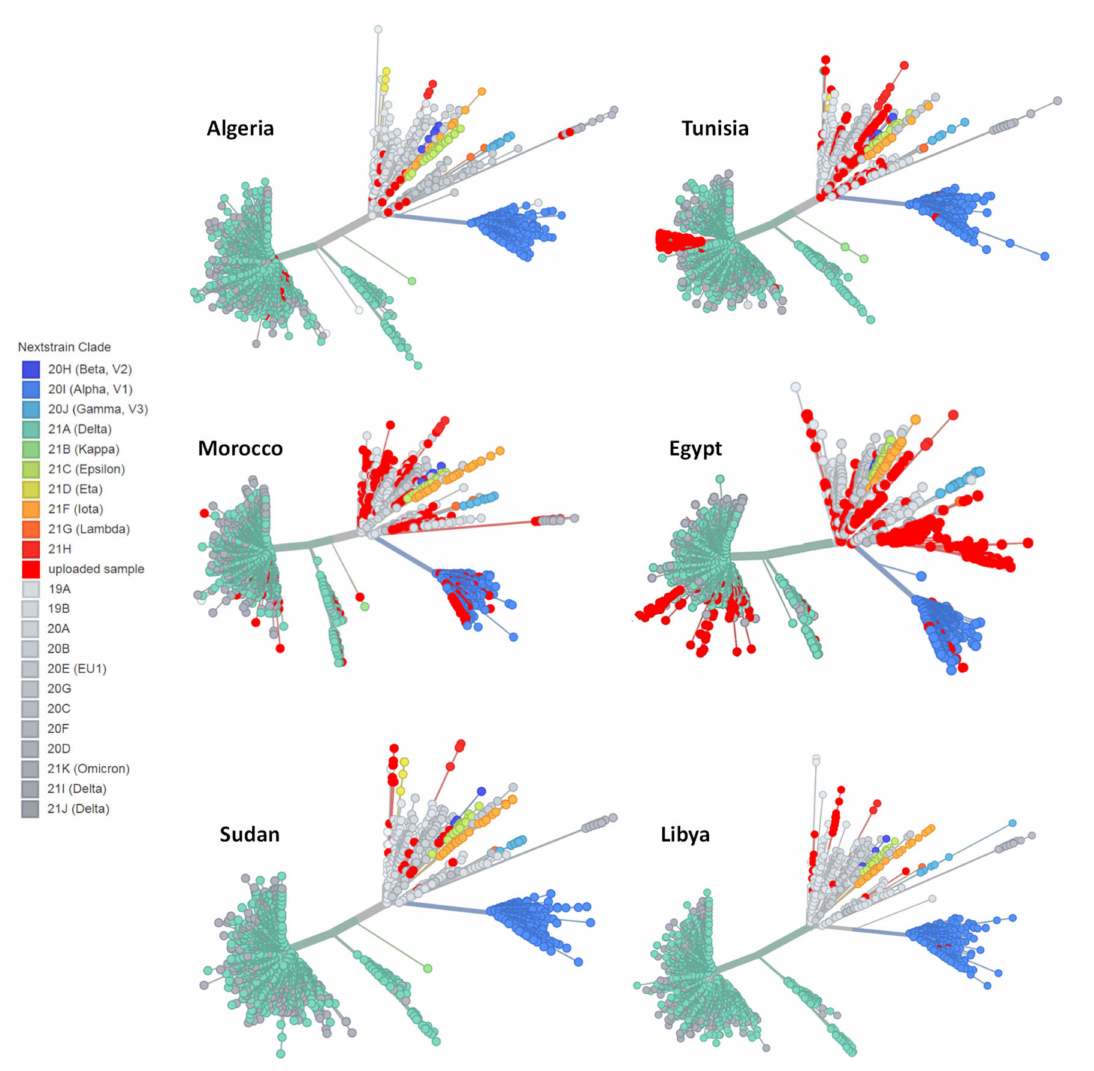
Figure 4. Unrooted phylogenetic relationship of analyzed SARS-CoV-2 sequences from North African countries to the global SARS-CoV-2 genomes. Clades distribution according to the Nextclade online tool (https://clades.nextstrain.org/) (accessed on 30 December 2021) and the phylogenetic tree was generated using the UShER